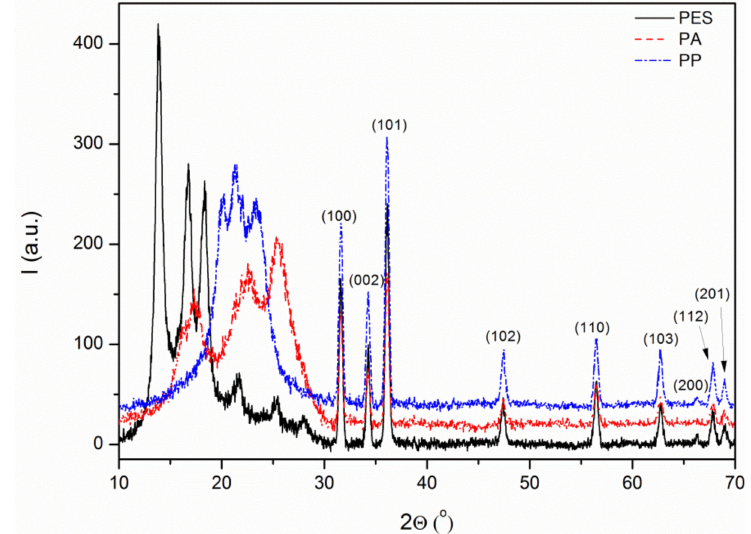
Figure 5. XRD diffractograms of modified textiles.